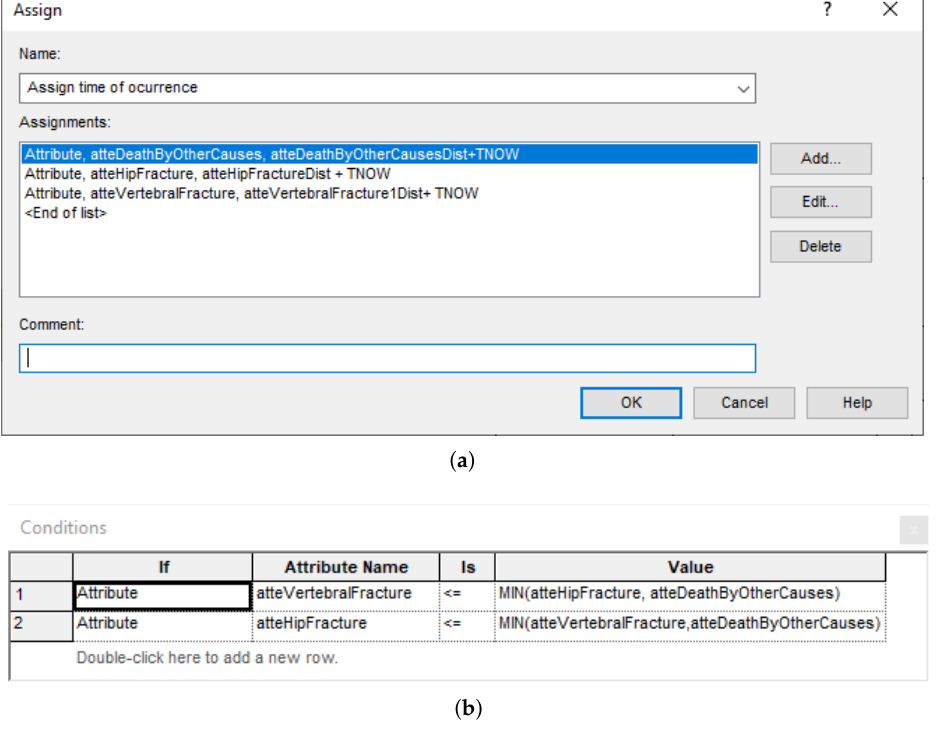
Figure A8. Explicit computations in Arena blocks. ( a ) Block of type ‘Assign’ for setting the occurrence time of the next events. ( b ) Block of type ‘Decide’ for selecting the next